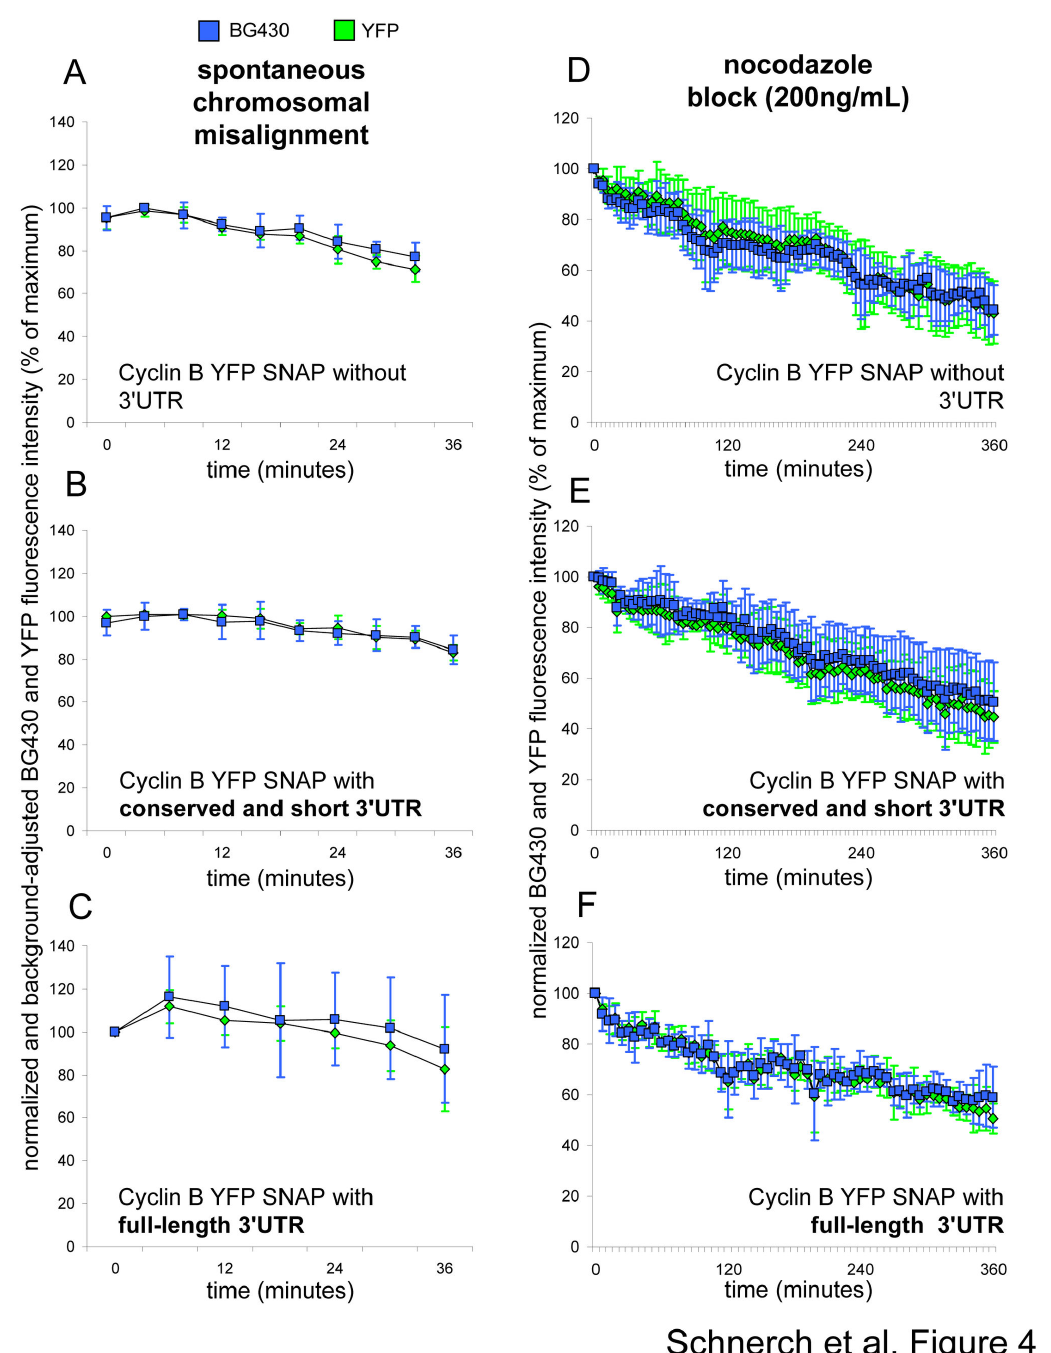
Figure 4. Whole protein expression and degradation of the cyclin B reporter during a mitotic delay/block in the presence or absence of the cyclin B 3'UTR in U2Os cells. YFP and BG430 fluorescence intensity curves as determined by live-cell imaging. (A, D) The investigated cells express the CYS reporter without an endogenous cyclin B 3'UTR, (B, E) with a short/ conserved (C, F) and a long 3'UTR sequence. Cells displaying spontaneous chromosomal misalignment that indicates an active SAC are shown in A-C (mean fluorescence intensities +/- SD are indicated, n=4). Cells that are arrested in a mitotic block using a final nocodazole concentration in the growth medium of 200ng/mL are depicted in D-F (mean fluorescence intensities +/- SD are indicated, n=4). For every shown experimental setting the analyzed cells are representatives of three independent experiments each of which included at least 50.000 cells. doi: 10.1371/journal.pone.0074379.g004 PLOS ONE |